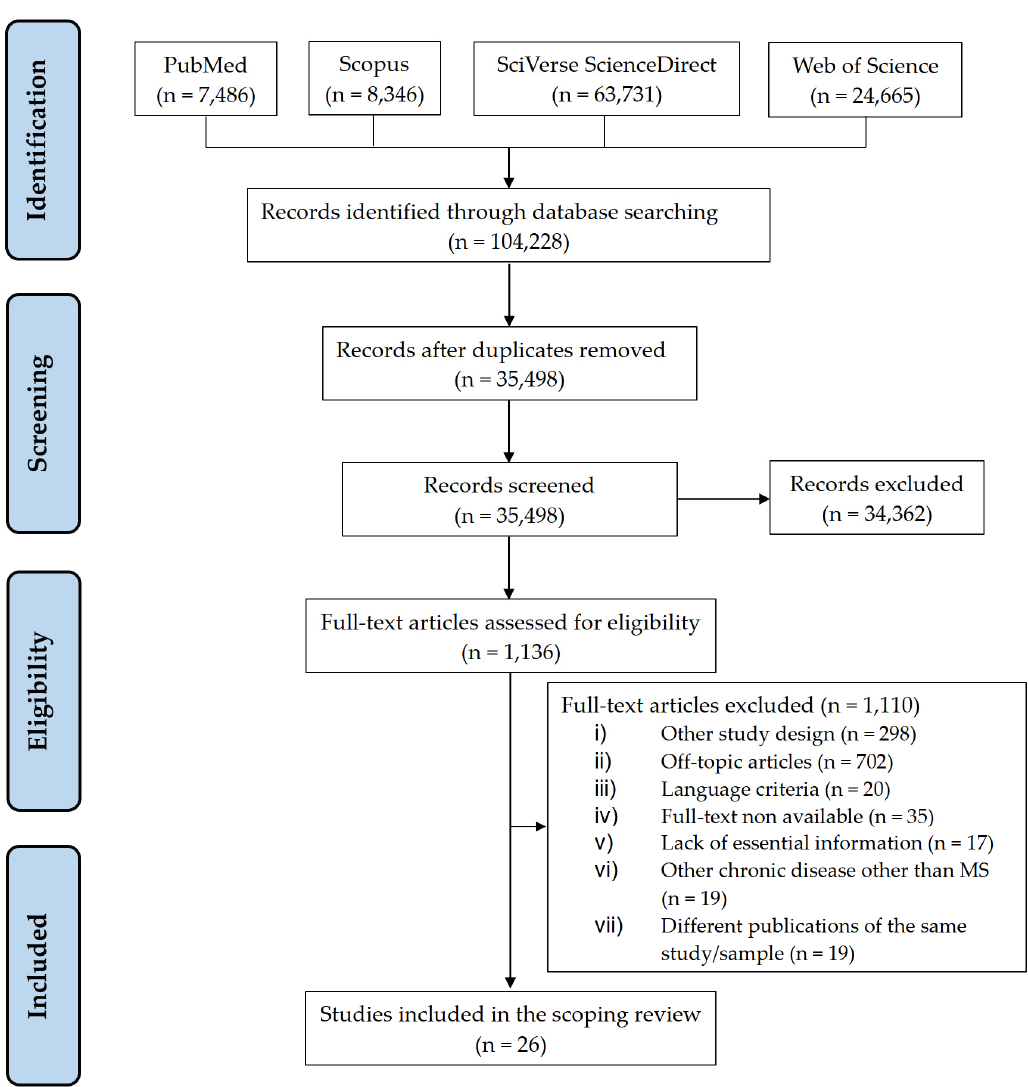
Figure 1. PRISMA flowchart.